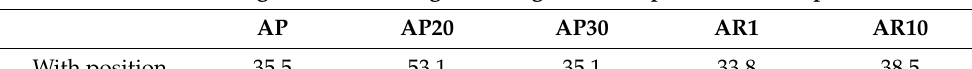
Table 2. Model metrics comparison in position encoding and backbone contrast. AP is average precision (%), AR means average recall (%).